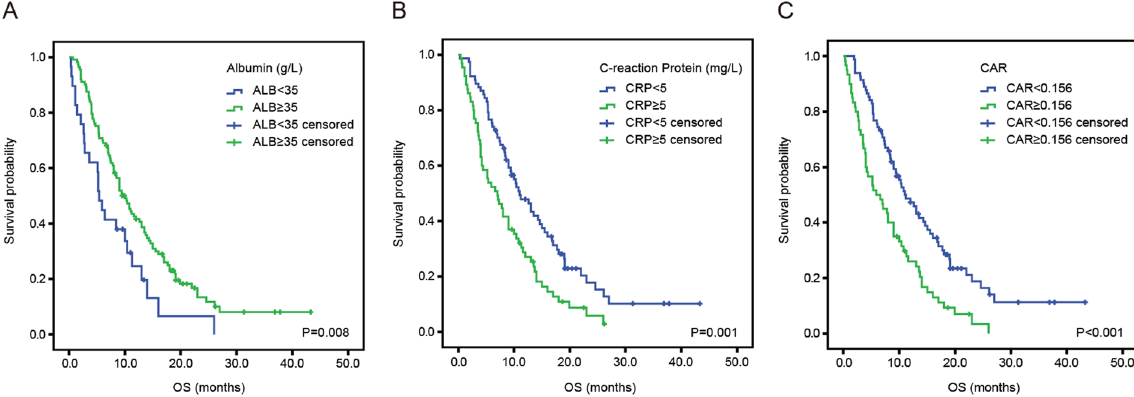
Figure 3. Kaplan-Meier estimates of overall survival according to the level of serum albumin ( A ), CRP ( B ) and CAR ( C